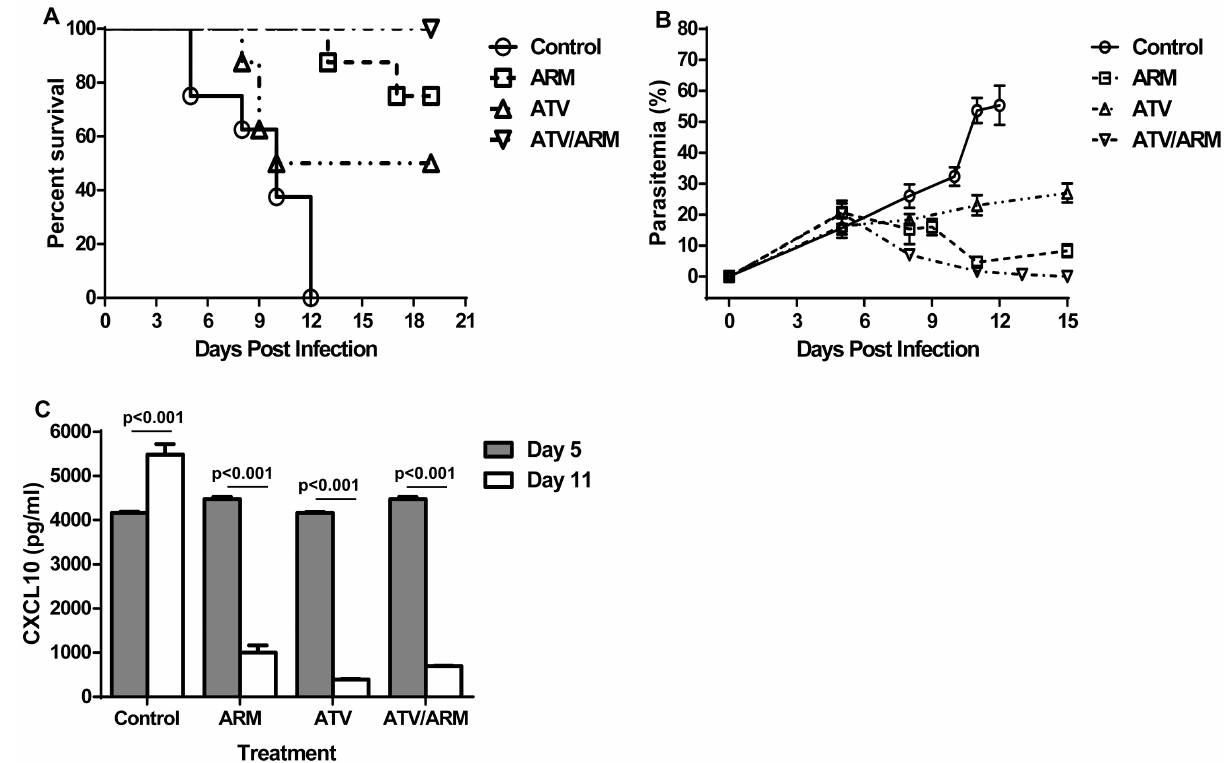
Figure 2. Modulating CXCL10 levels improves survival in mice with late stage ECM. (A) Survival curves: The Kaplan-Meier curves are shown for efficacy of ARM at 25 mg/kg/day ( n =11), ATV at 25 mg/kg/day ( n =11) and ATV/ARM at 25 mg/kg/day ( n =11) in rescuing mice with late stage ECM. All treatments started no day 6 and ends on day 9 post infection. ARM-treated and ATV-treated mice showed survival rates of 75% and 50% respectively compared to controls (p , 0.05). The survival rates improved with ATV/ARM-treated mice (100%) which are significantly superior to ARM- treated, ATV-treated or control mice (p , 0.001). Survival was assessed twice daily. Significant differences in survival were assessed by Log rank test. (B) Parasitemia of P. berghei ANKA-infected mice after treatment. Parasitemia was monitored by Giemsa-stained blood smears using light microscopy at 6 100 magnifications with an oil immersion lens. Parasitemia was checked and quantified by counting the number of parasitized red blood cells in at least 1,000 red blood cells. The experiment is a representative of three independent infections. (C) Serum CXCL10 levels of P. berghei ANKA-infected mice after treatment. Serum CXCL10 was measured on samples collected on day 5 and day 11 post infection ( n =5 per group). The results in panels B and C are mean 6 the standard deviation. Mean values were determined to be significantly different using the student t -test. A p value of , 0.05 was considered significant. ARM=artemether; ATV=atorvastatin.